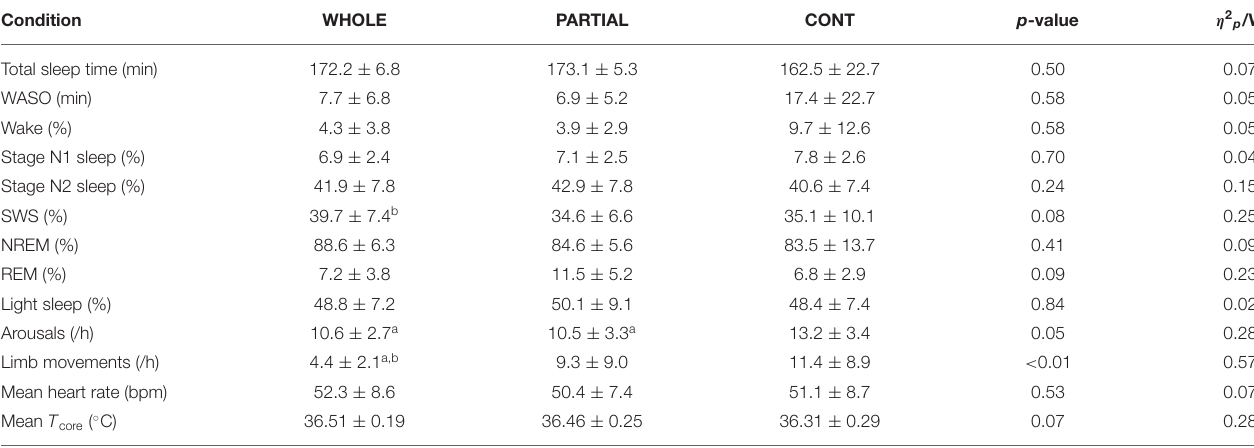
TABLE 2 | Polysomnography analysis, mean nocturnal heart rate, and T core during the first 180min after sleep onset in WHOLE ( n = 12), PARTIAL ( n = 12), and CONT ( n = 10) conditions. Condition WHOLE PARTIAL CONT p -value η 2 p /W Total sleep time (min) 172.2 ±